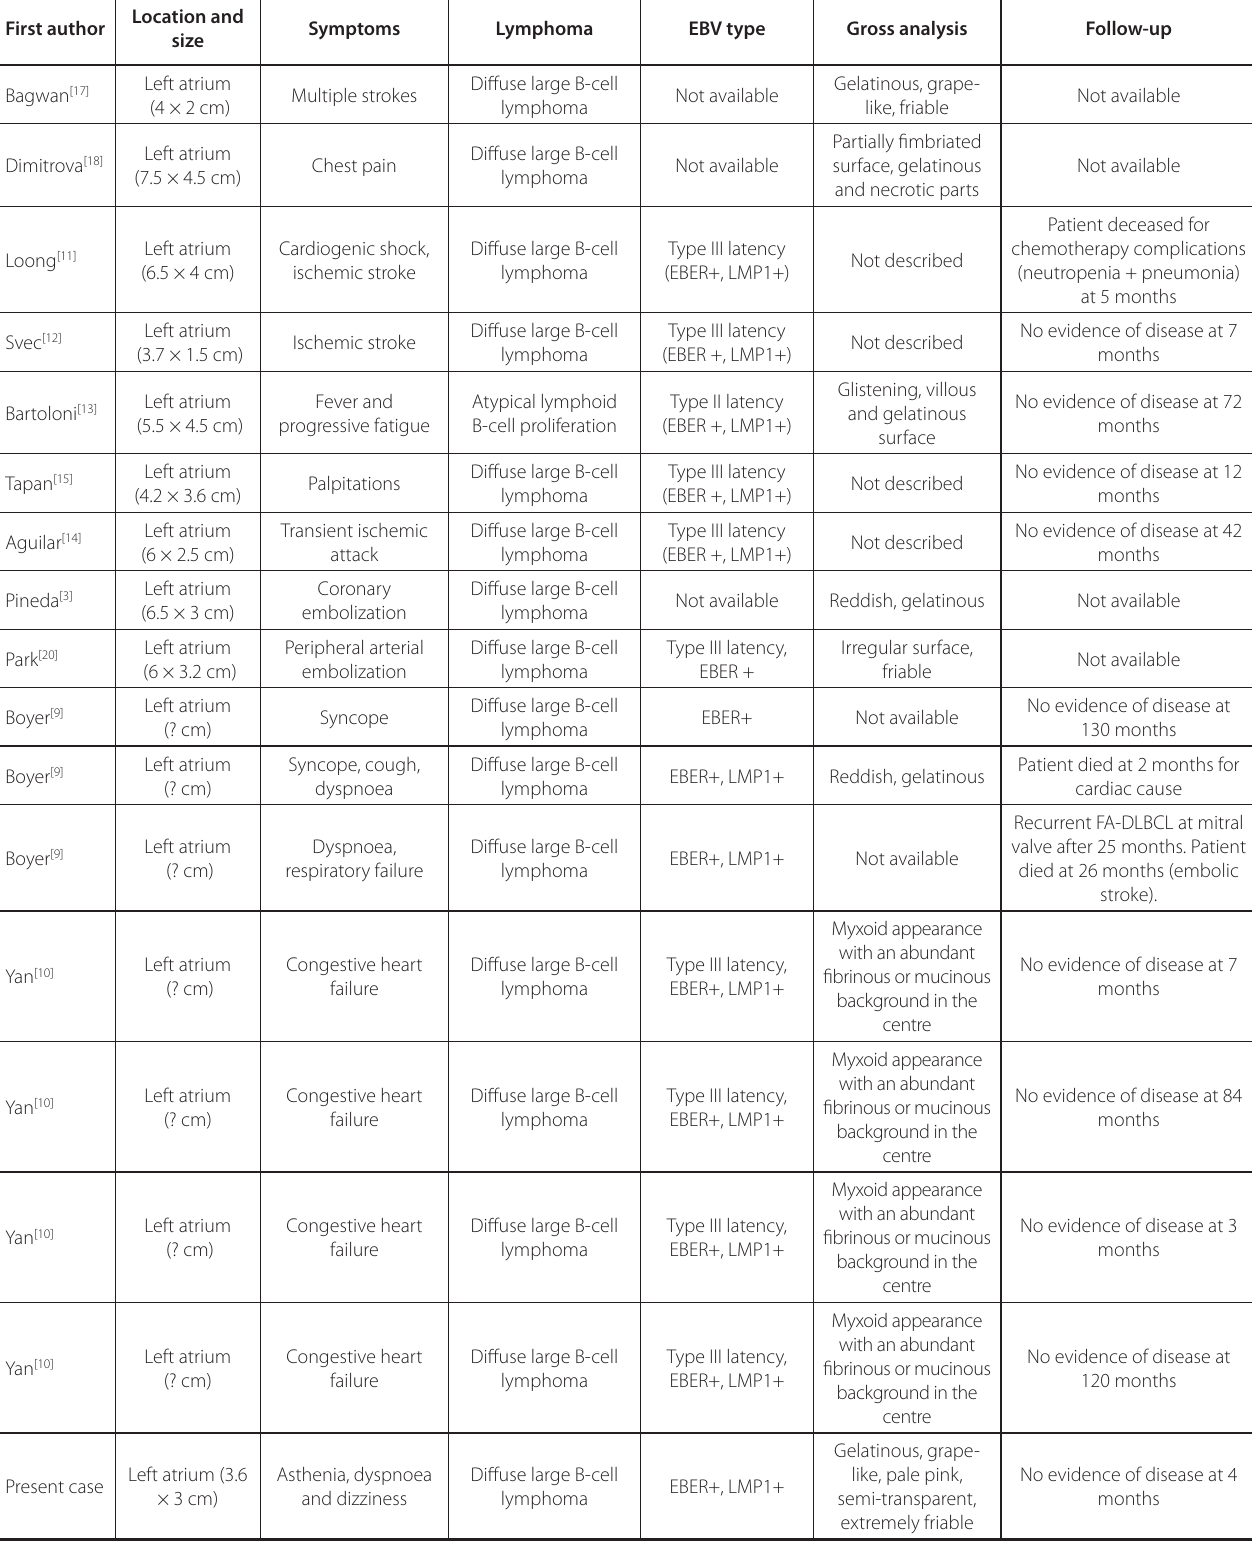
Table 1 . Available literature data regarding cases of myxomas in which B-cell lymphomas were